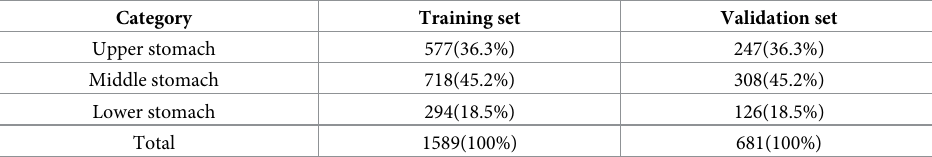
Table 1. Classification of the training image set and validation image